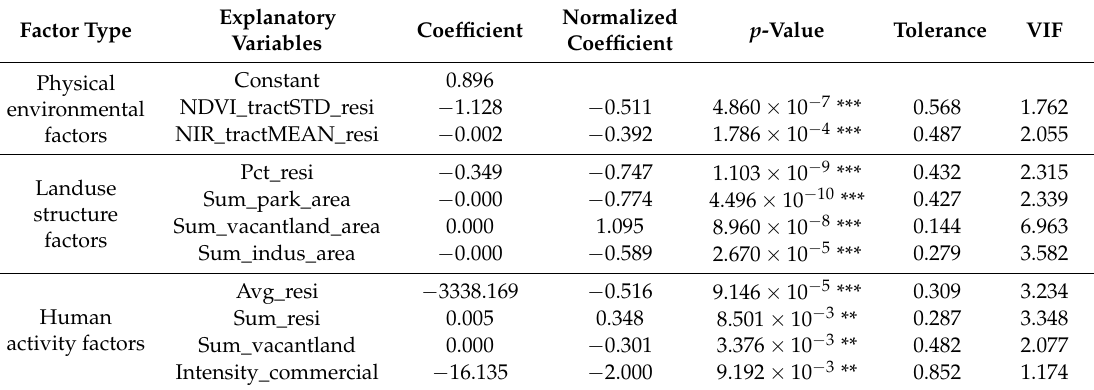
Table 5. Stepwise Multivariate Linear Regression Model 2 (with Jilin1-03 satellite NTL data).